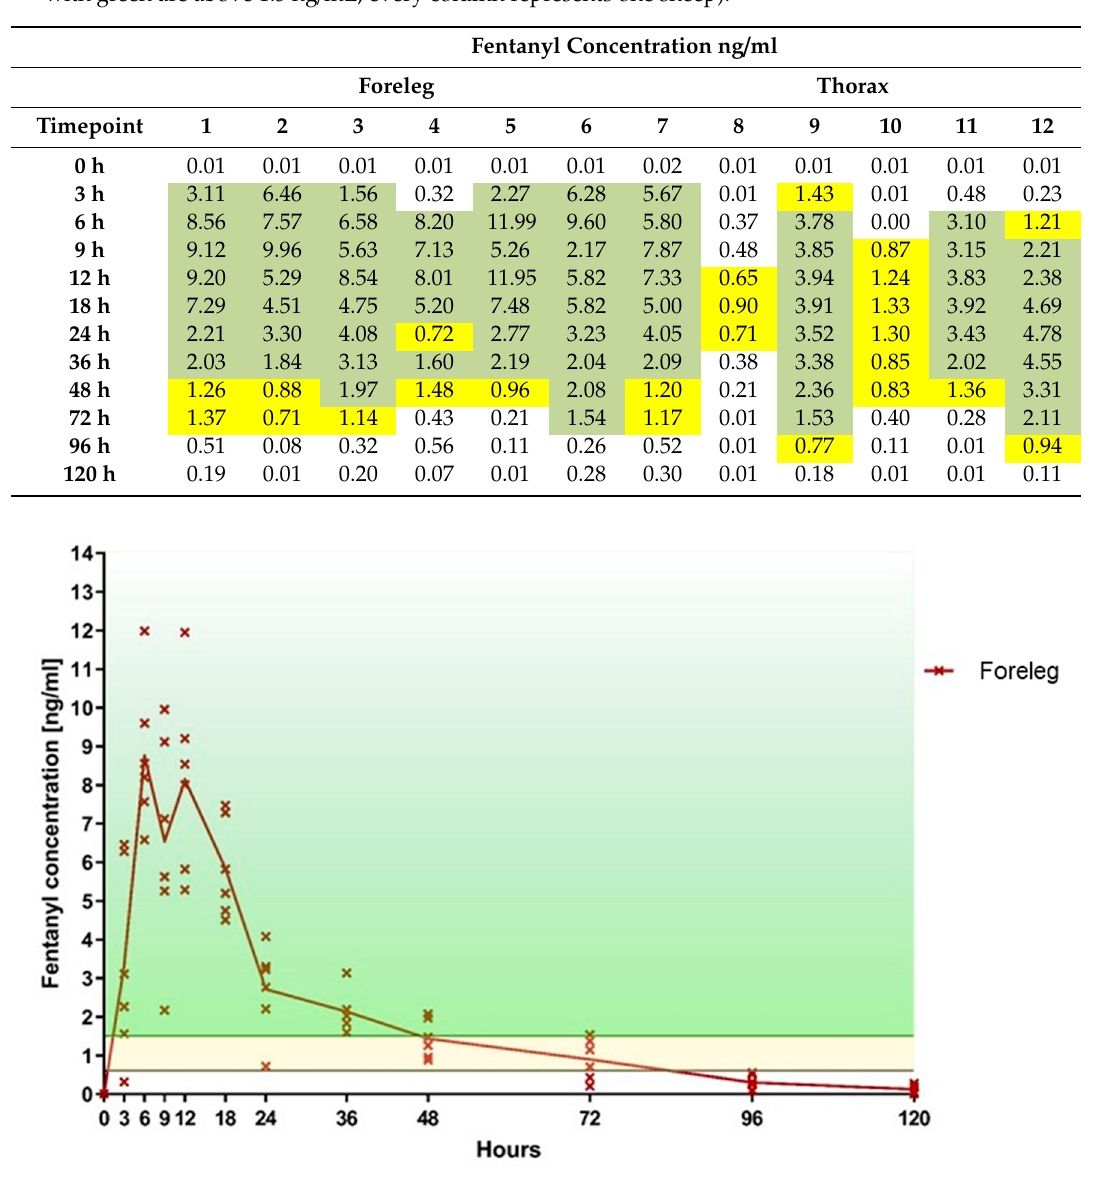
Figure 4. Foreleg—Fentanyl plasma level over time (the fentanyl level within the area marked in yellow, correspond to the minimal analgesic plasma level of 0.6–1.5 ng / mL described for humans; the area above marked in green represents values higher than 1.5 ng / mL).